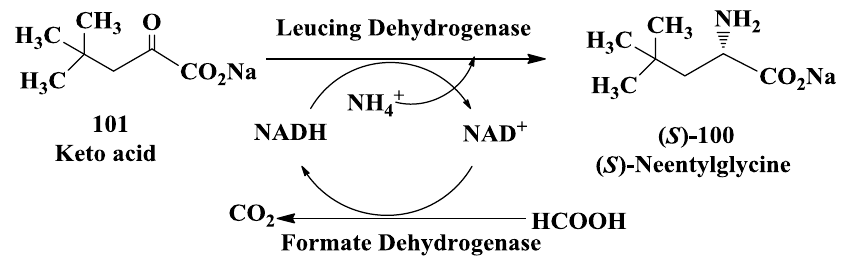
Figure 27. Enzymatic synthesis of ( S